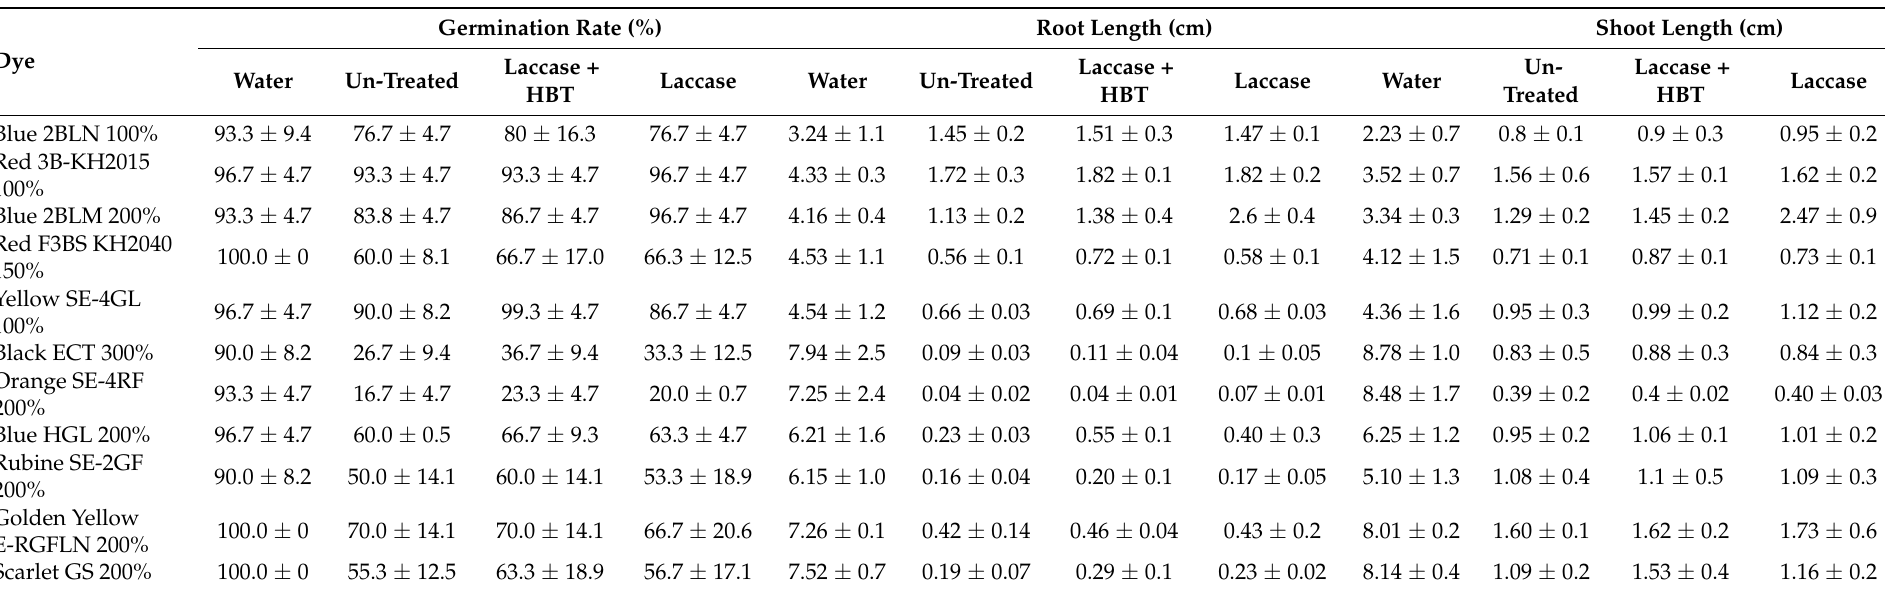
Table 2. Germination rate and root and shoot length of wheat seed exposed to dye solution with or without laccase decolorization. The initial dye concentration was 50 mg/L, and the decolorization of each dye was achieved under its respective optimized